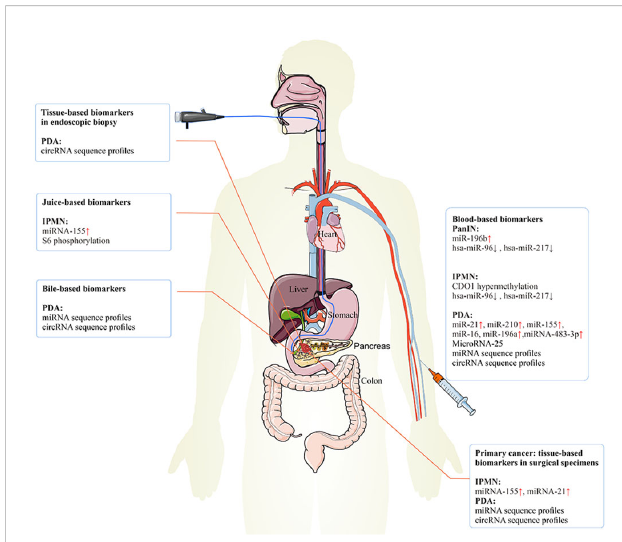
FIGURE 3 The epigenetic biomarkers for early PC detection. The epigenetic biomarkers or regulators can be exploited for clinical detection and diagnosis of early PC. Tissue-based biomarkers in endoscopic biopsy specimens may be used clinically to improve the prediction of the risk of PC. Tissue-based biomarkers in surgical specimens may have diagnosis value in IPMN and PC. Blood-based biomarkers may have diagnosis value in PanIN, IPMN, and PC. Juice-based biomarkers may have diagnosis value in IPMN. Bile-based biomarkers may have diagnosis value in PC. PC, pancreatic cancer; IPMN, intraductal papillary mucinous neoplasm; PanIN, pancreatic intraepithelial